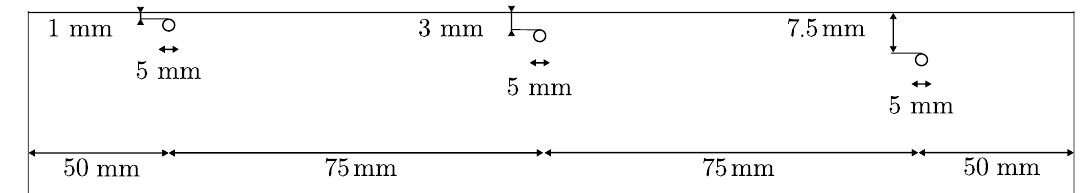
Figure 2. Schematic representation of the test sample presenting three SDHs of 2.5 mm radius, located at depths of 1, 3 and 7.5 mm